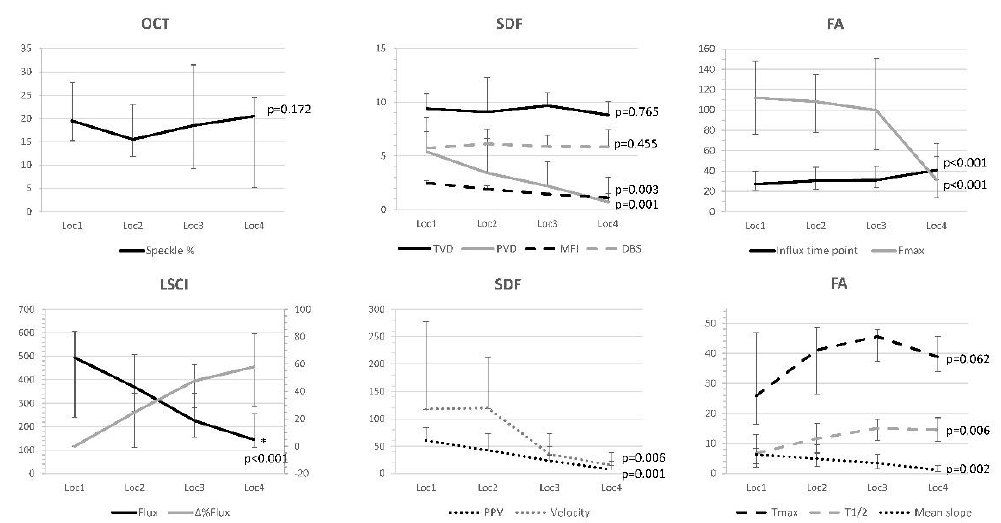
Figure 2. Fourteen quantitative parameters at four locations of the gastric conduit. Data are shown as medians and interquartile ranges. p -value is shown for the di ff erence between Loc1 and Loc4. OCT Optical Coherence Tomography: Speckle in %. SDF Sidestream Darkfield Imaging: TVD total vessel density in mm / mm 2 , PVD perfused vessel density in mm / mm 2 , MFI microvascular flow index, DBS de Backer score, PPV proportion (%) of perfused vessels. LSCI Laser Speckle Contrast Imaging: Flux in LSPU (laser speckle perfusion units), ∆ %Flux percentage di ff erence in Flux relative to Location 1 (right vertical axis). * Not calculated, p -value calculated on absolute data (see Flux). FA Fluorescence Angiography: Influx time point in sec, F max in arbitrary units, T max in sec, T 1 / 2 in sec, mean slope in arbitrary units per sec.